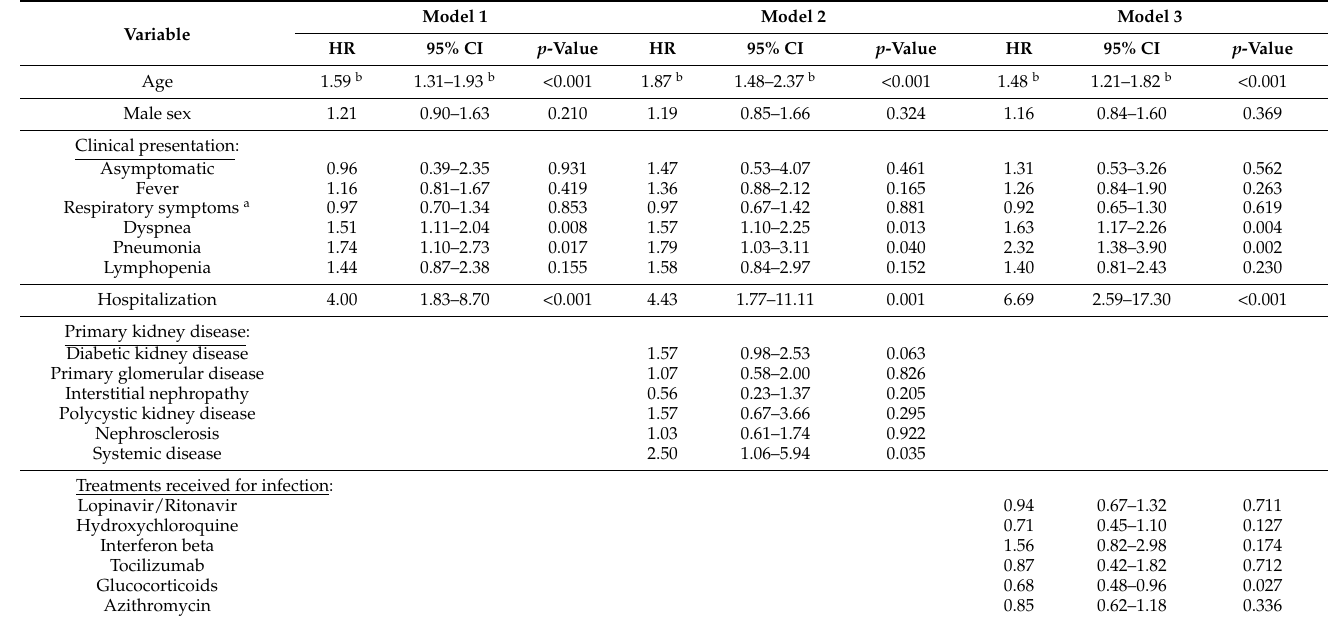
Table 4. Multivariate Cox regression of risk factors for mortality in haemodialysis elderly patients with COVID-19. The hazard ratio (HR) for mortality and its 95% confidence interval are shown for each factor included in the regression model.